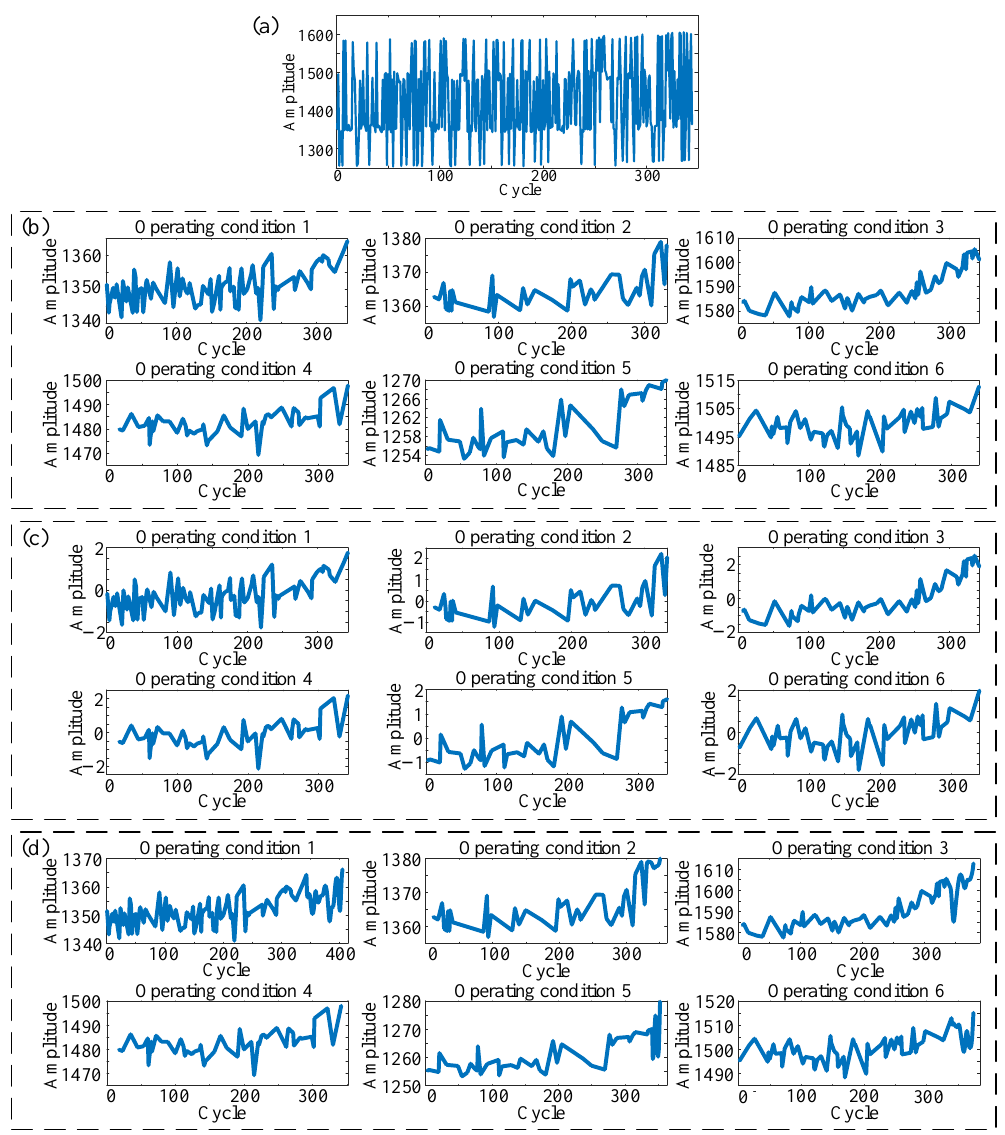
Figure 7. The construction process of the reference degradation model. ( a ) One of the similarity reference samples, which is selected from the historical sample by measuring the similarity between the sample to be predicted and the historical sample. ( b ) The operating condition partition of the similarity reference sample. ( c ) The standardization of operating conditions. ( d ) The predicted degradation trend of each constant operating condition by RVM.